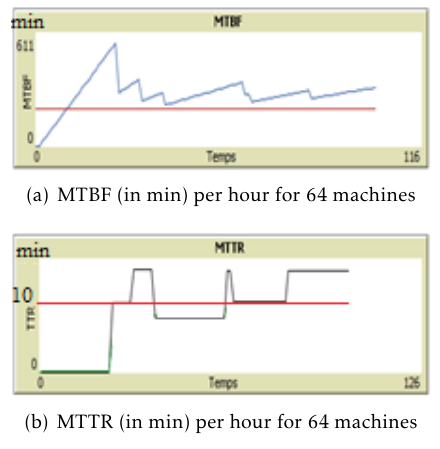
describes boundary condition: fixed type for the case of walls as obstacles and reflexive type for the case of door which can contains agents. There are 3 available agents in the bu ff er zone and 74 machines disposed grouped in 3 types (T1, T2, T3) with particular MTBF and MTTR.